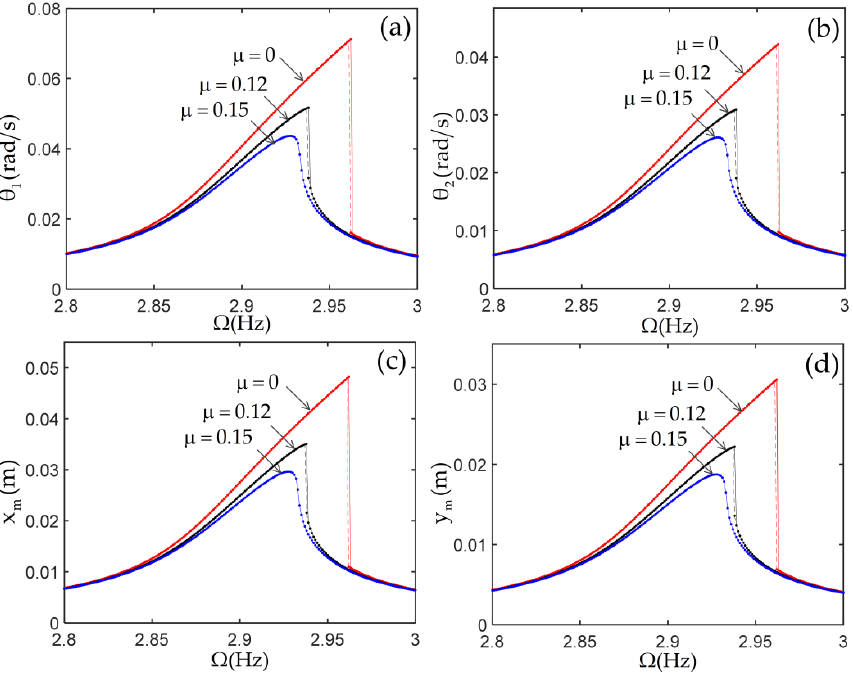
Figure 12. The frequency response curves of the structure with various joint damping μ . ( a ) the displacement of first joint; ( b ) the displacement of second joint; ( c ) the horizontal displacement of tip mass; ( d ) the vertical displacement of tip mass.